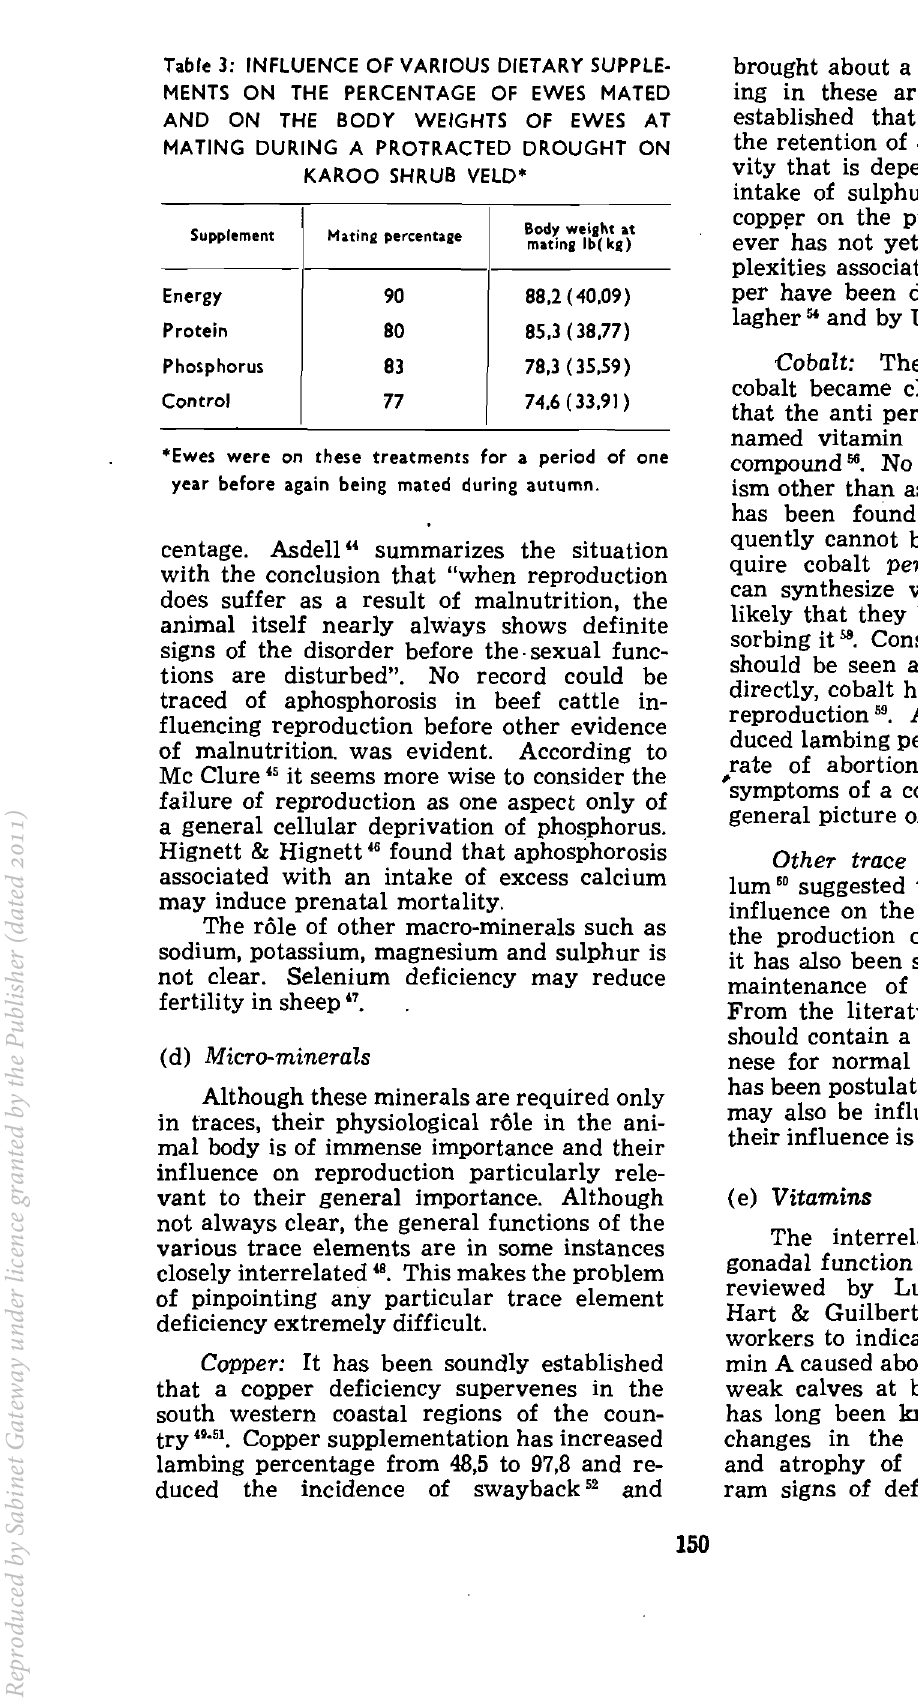
Table 3: INFLUENCE OF VARIOUS DIETARY SUPPLE· MENTS ON THE PERCENTAGE OF EWES MATED AND ON THE BODY WEIGHTS OF EWES AT MATING DURING A PROTRACTED DROUGHT ON KAROO SHRUB